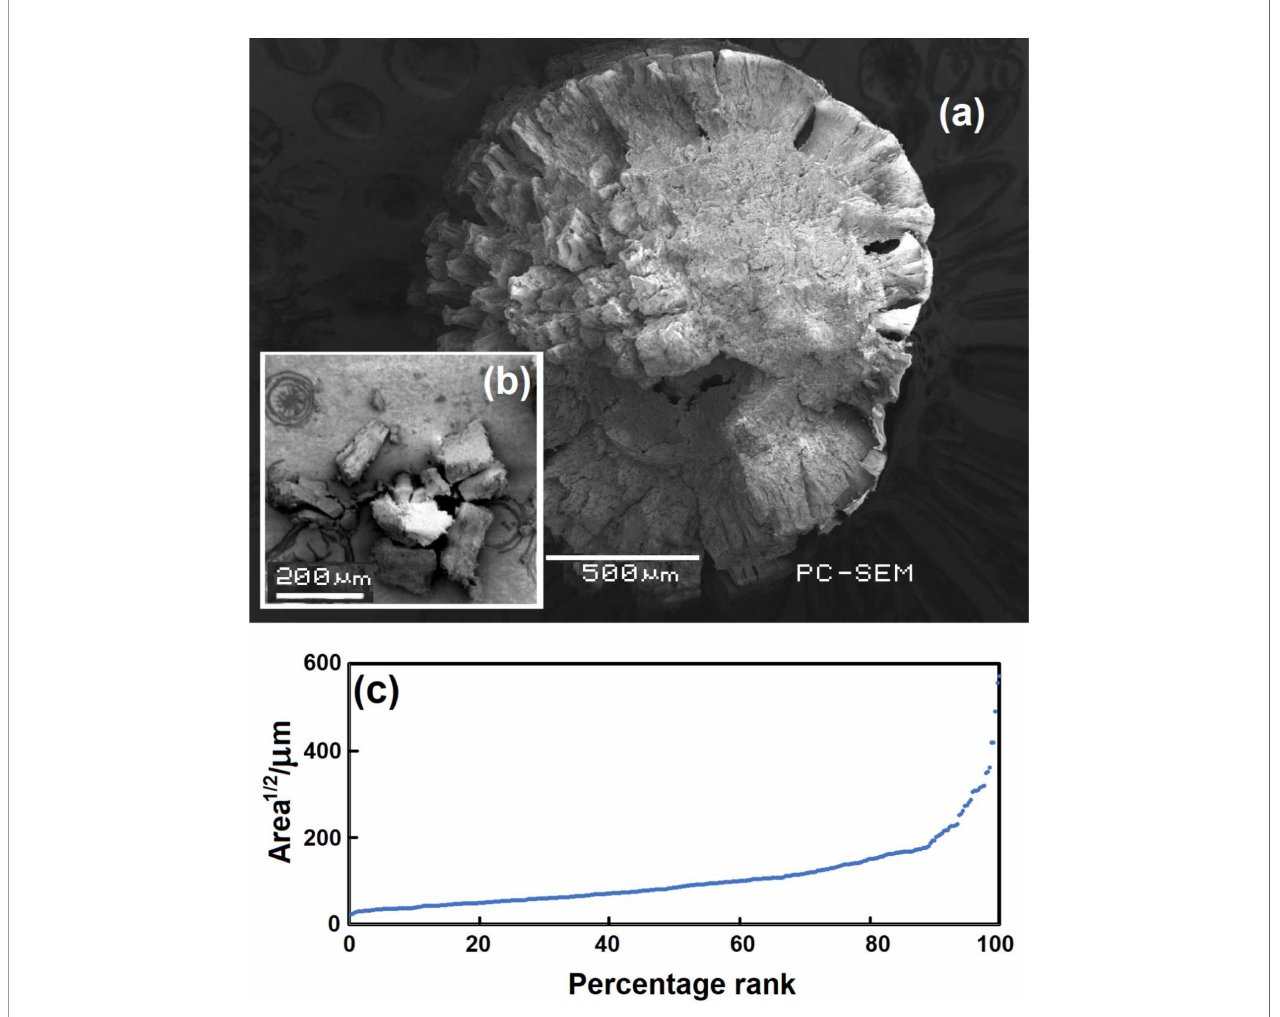
FIGURE 3 | (A) Pellet split in half after exposure to sunlight for 3.5 years. (B) Typical fragments, which separate after sunlight exposure. (C) Ranked dimension of fragments separating from pellets exposed to